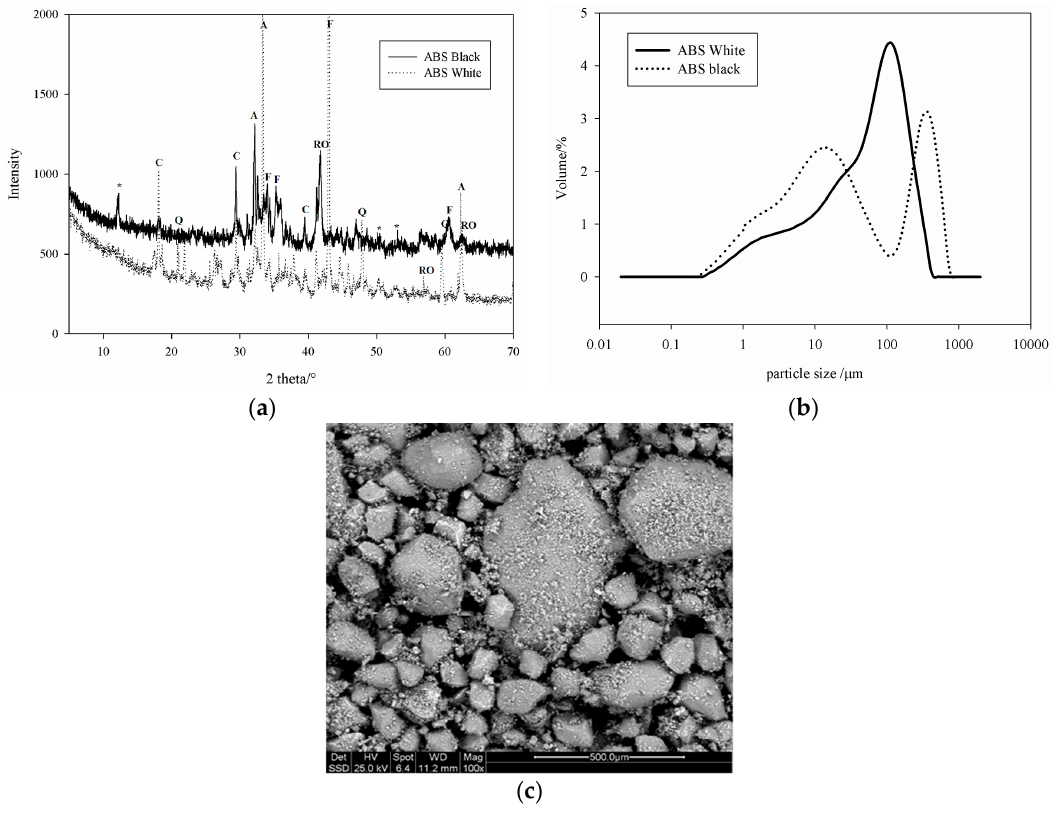
Figure 1. Characterization of the starting two steel slags used for this study: ( a ) XRD patterns (C = Ca(OH) 2 ; CF = x CaO y Fe 2 O 3 ; CS = C 2 S + C 3 S; Q = quartz; RO = pyroxenes solid-solution); ( b ) grain size distribution; ( c ) powder morphology with ESEM.